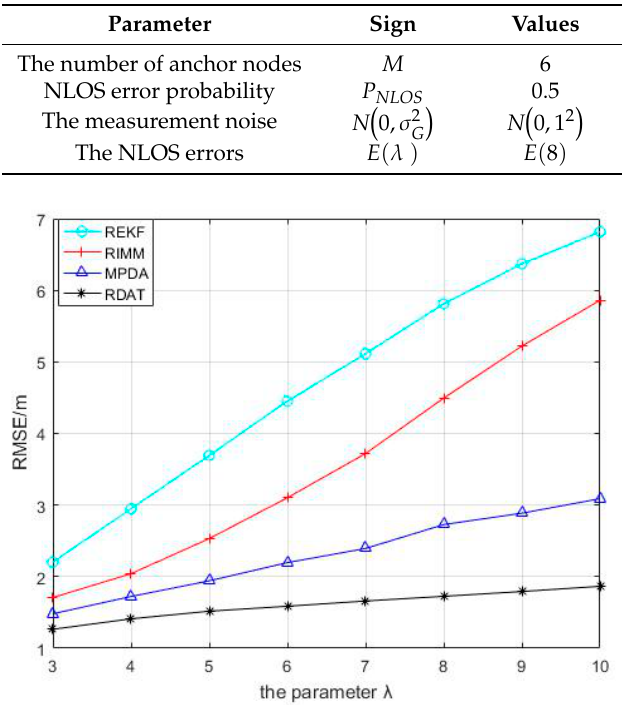
Figure 9. Performance contrast between RIMM, REKF, MPDA, and RDAT with di ff erent parameters of index distribution, where P NLOS = 0.5, N 0,1 2 and E ( 8 ) .